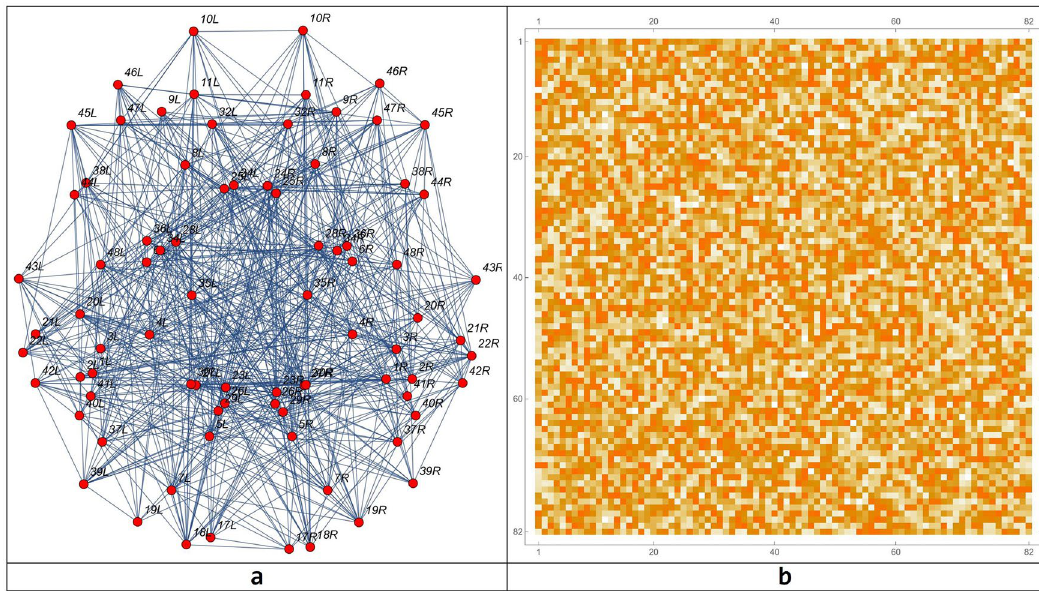
Figure 3. The connectome modelled on the 82 Brodmann areas ( a ) and the network connection matrix ( b ). The parcelization method adopted is as in 72